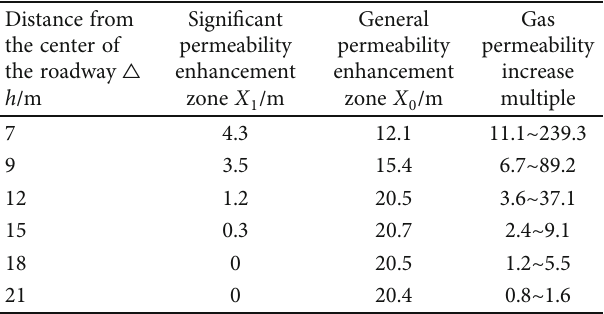
Figure 6: Axial unloading mechanics-permeability characteristic curves of di ff erent con fi ning pressure specimens. Table 1: The permeability enhancement e ff ect of coal seams with di ff erent Δ h